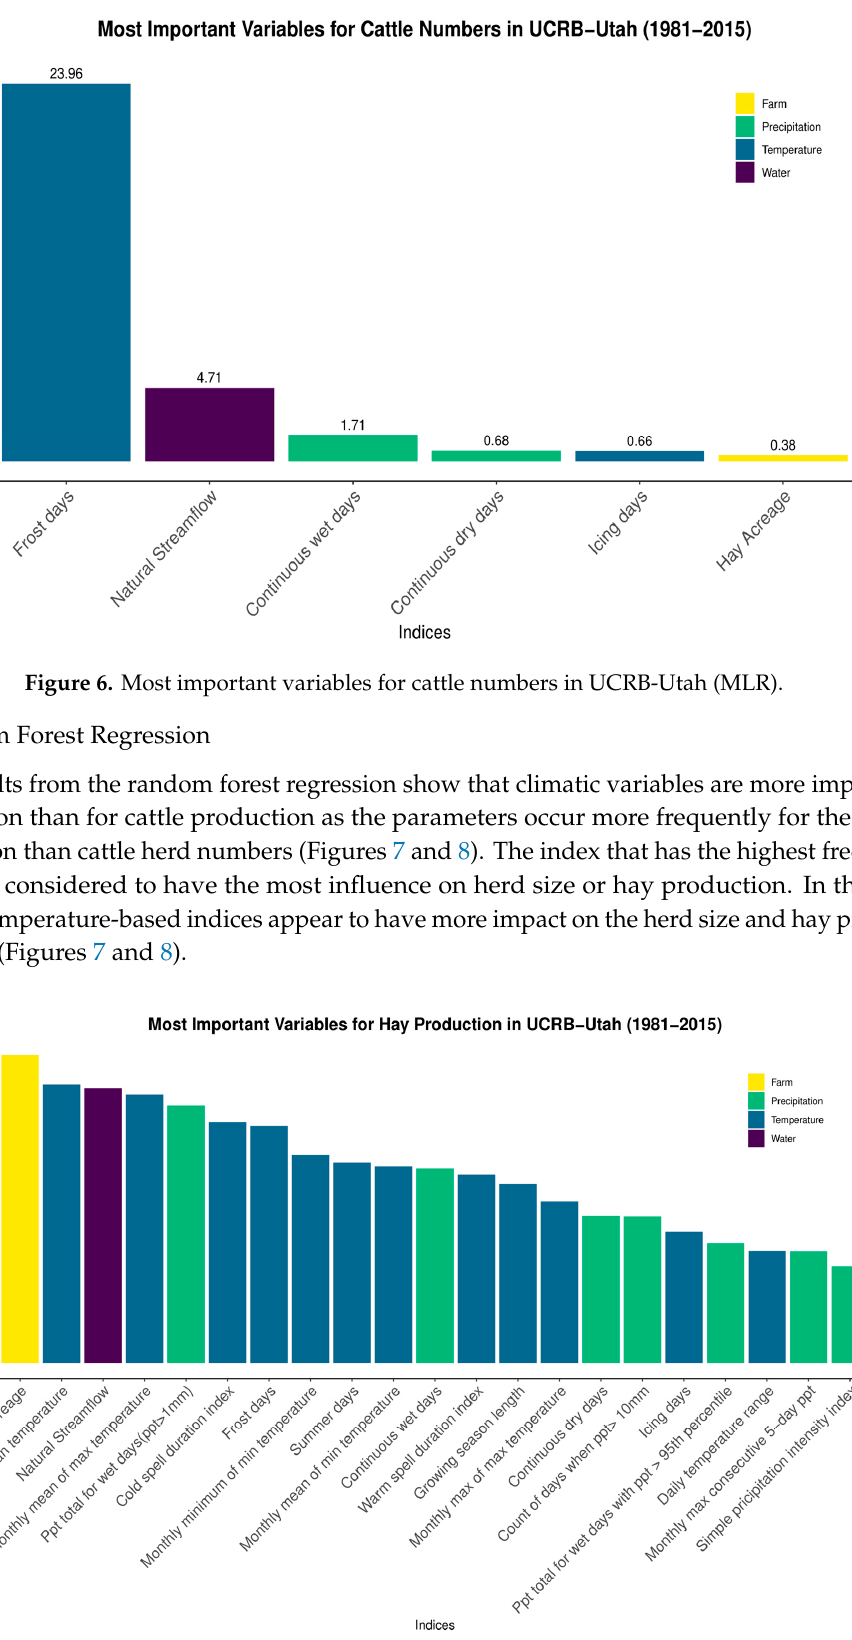
Figure 8. Most important variables for cattle herd size in UCRB-Utah (RFR).